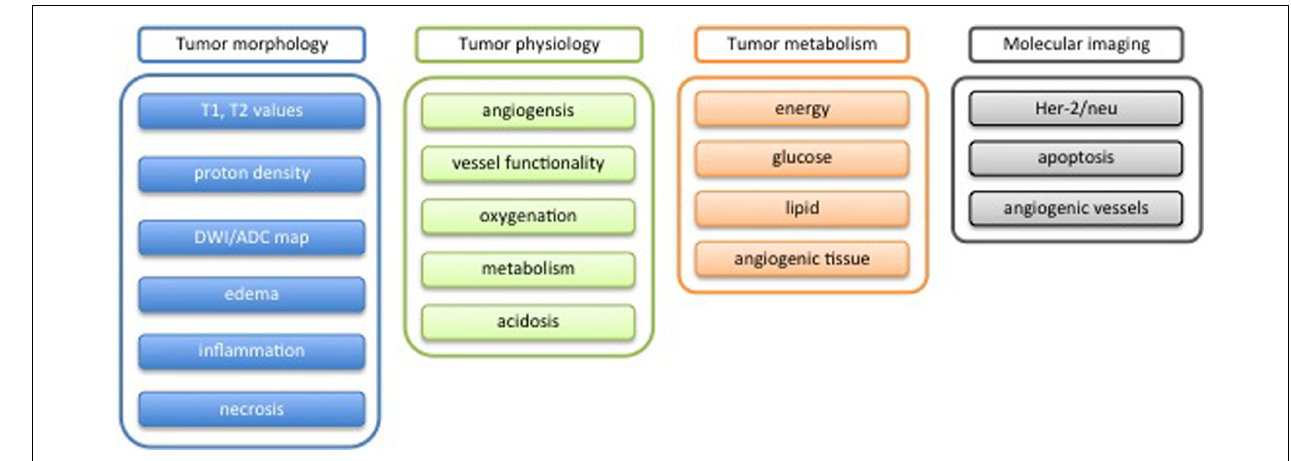
FIGURE 8 | Scheme for potential tumor phenotypic characterization by mean of MRI .